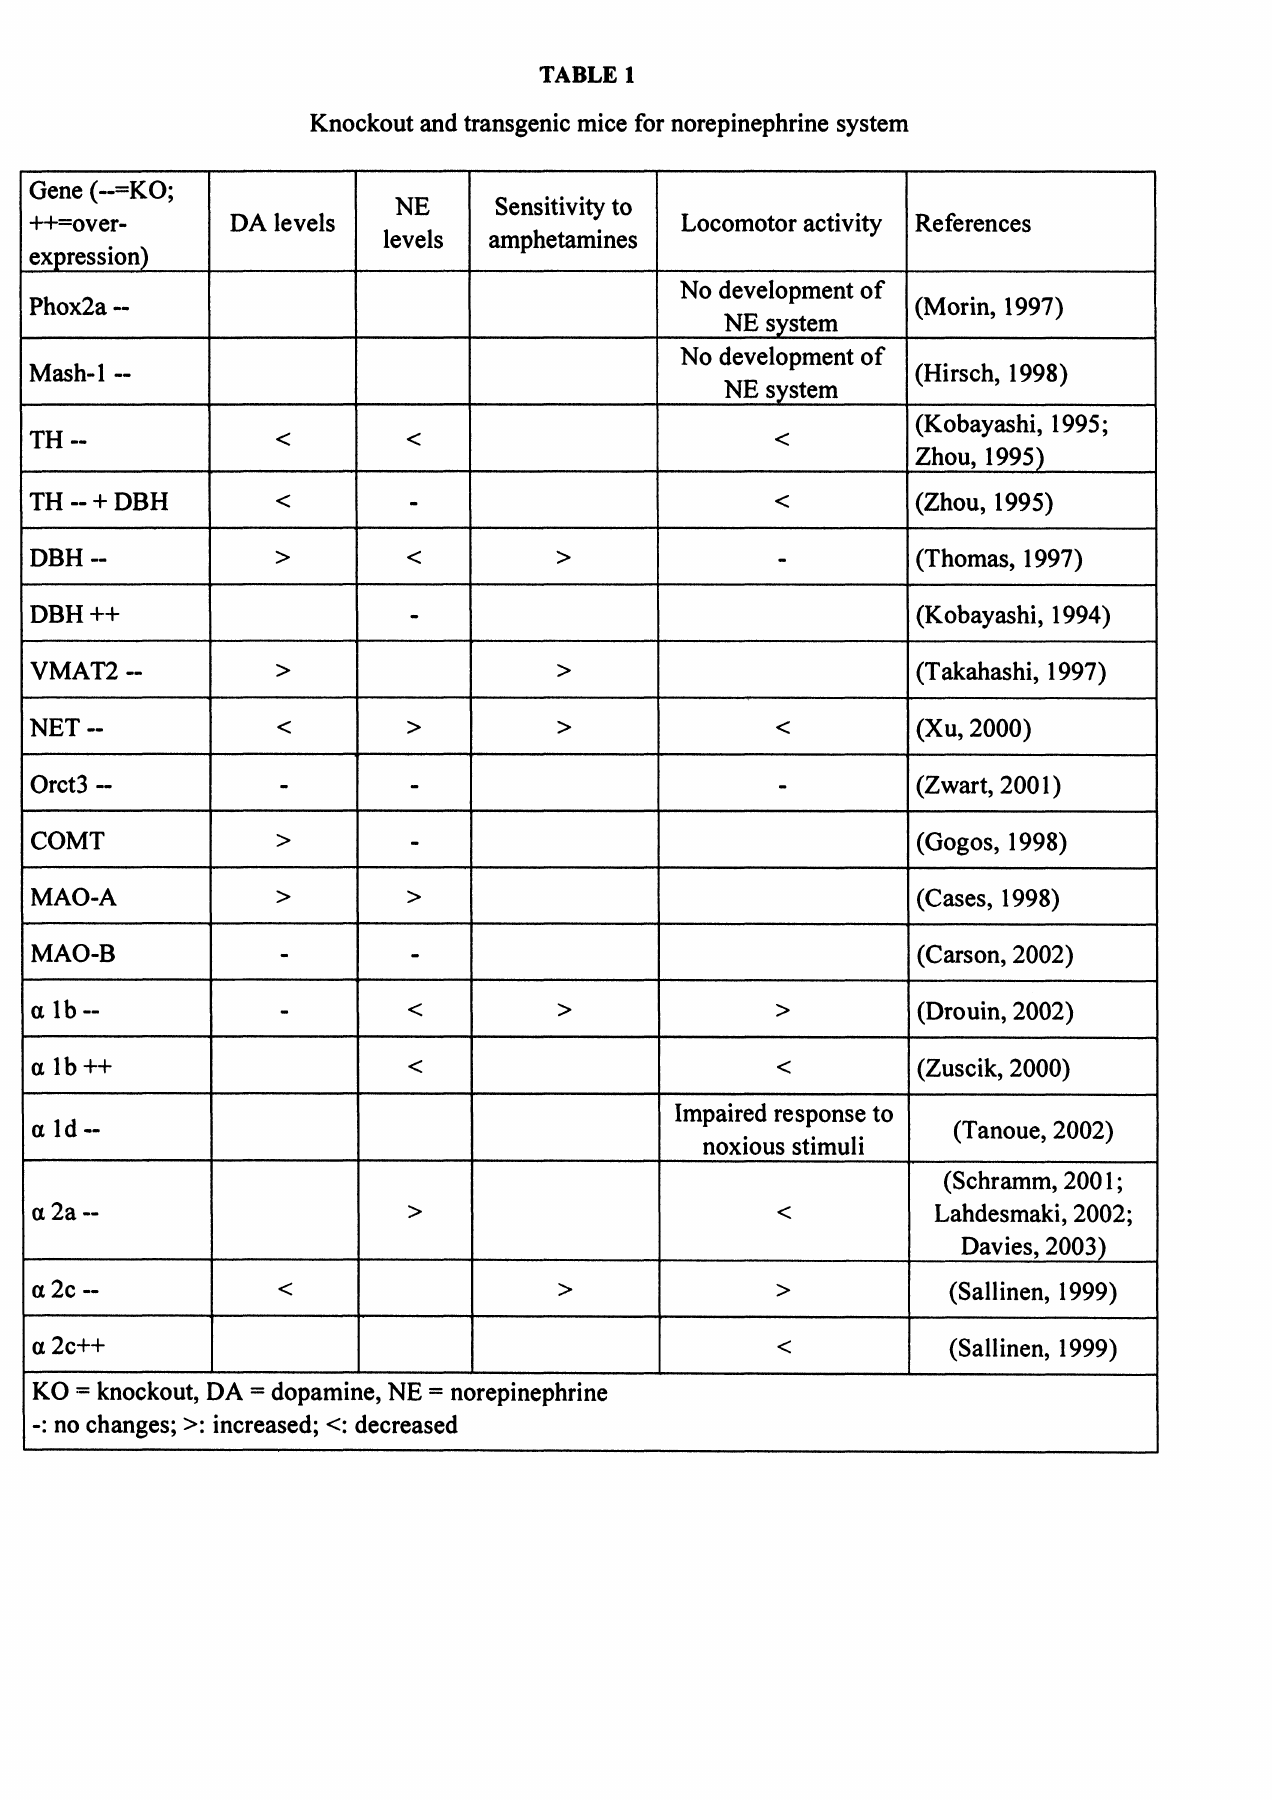
Knockout and transgenic mice for norepinephrine